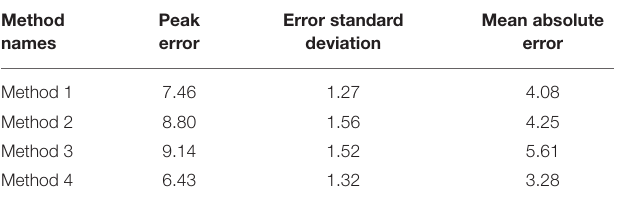
TABLE 3 | Tracking error statistics (unit: pixel).